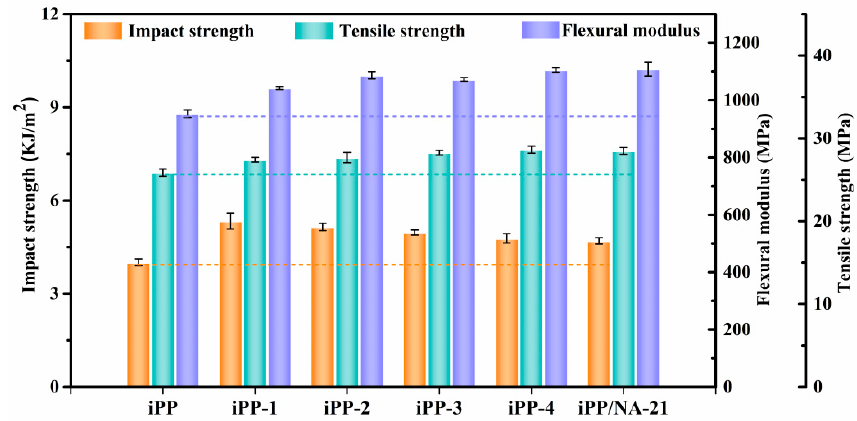
Figure 12. The mechanical properties for the iPP/A12C-Li composites. Table 3. The mechanical performances for the iPP/A12C-Li composites. Impact Strength Sample (KJ/m 2